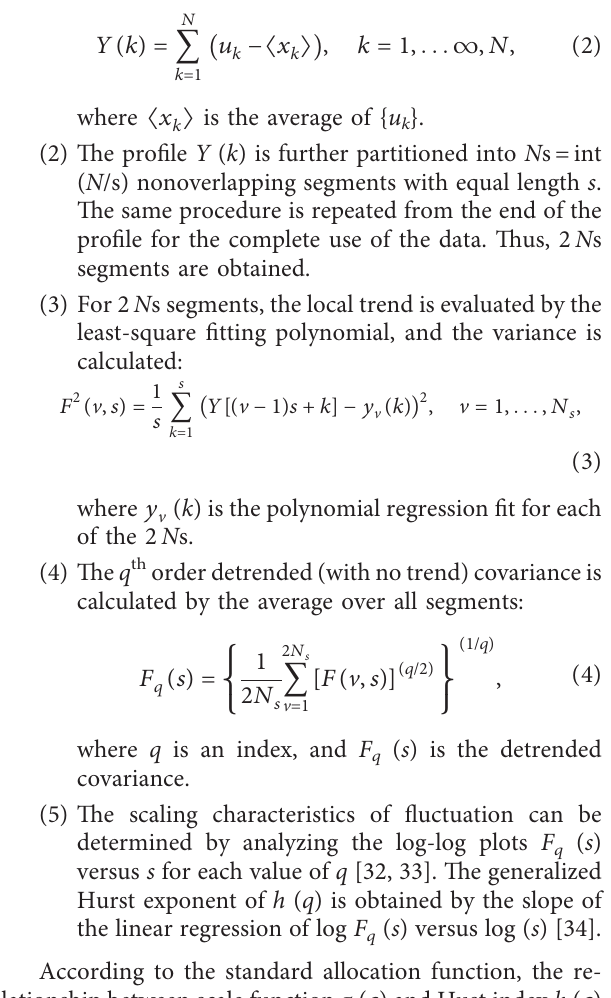
Table 1: Concrete mixture